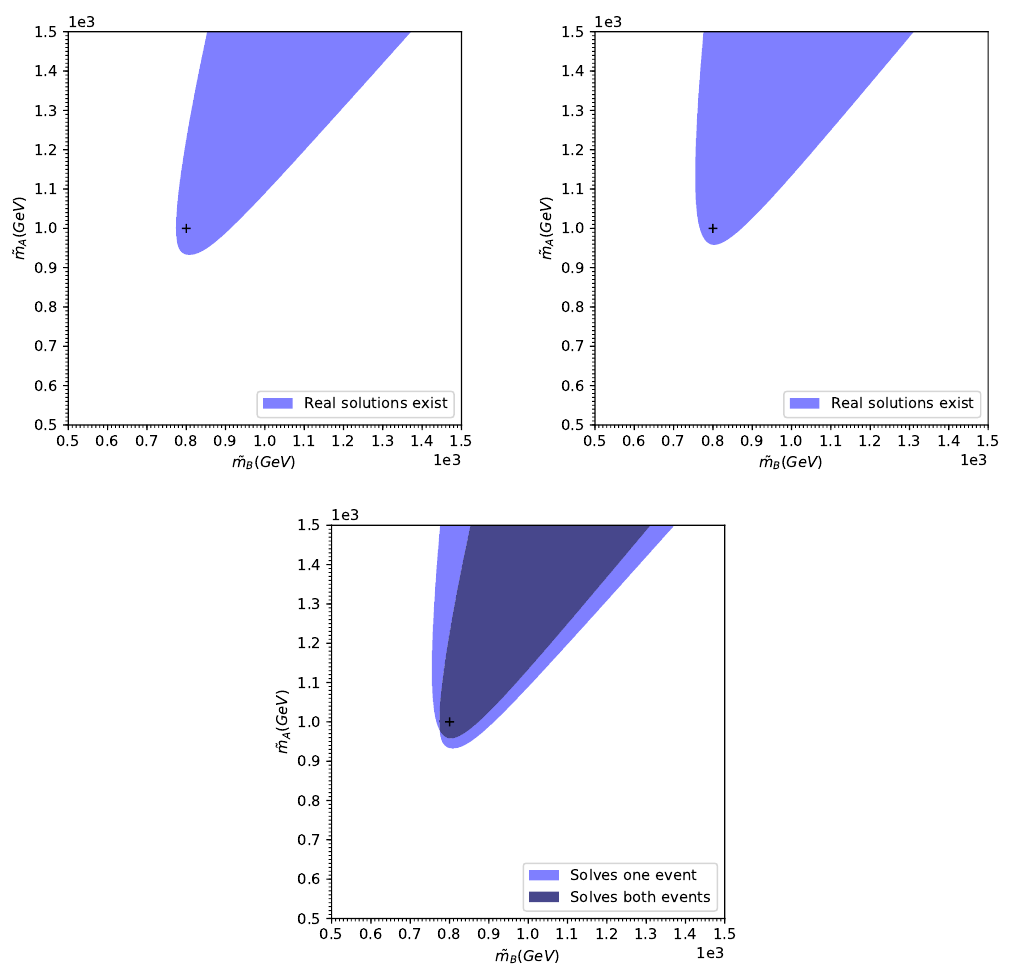
Figure 5 . Top row: the same as (cid:12)gure 2 ( ~ m = m = 700 GeV), only now the allowed region is C C uniformly shaded (in light blue), regardless of the number of real solutions. Bottom row: superpo- sition of the allowed regions from the two events. White areas are incompatible with both events, light-shaded areas solve one event but not the other, while the dark-shaded area solves both